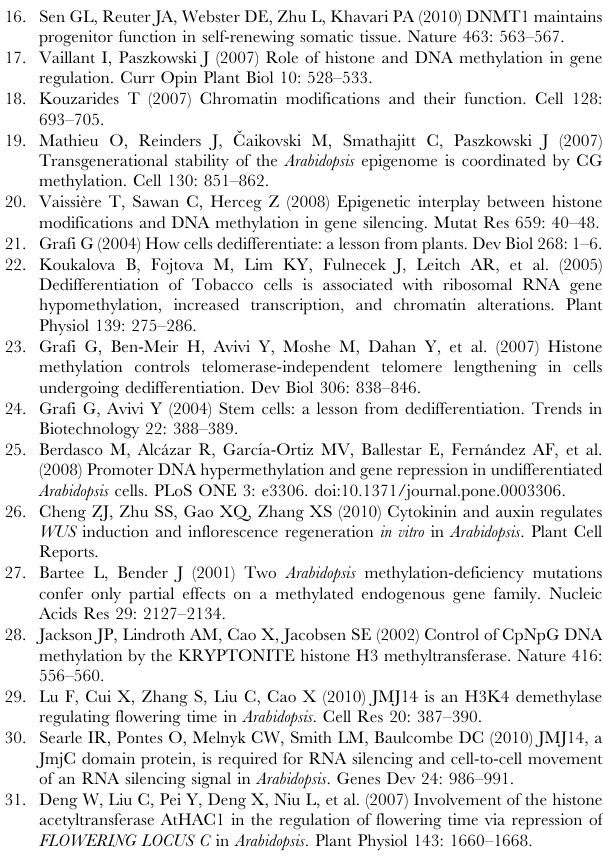
Figure S2 MET1 mutation promotes shoot regeneration in Arabidopsis using roots as explants. Calli of the wild type (Ws) and the met1 mutant were cultured on SIM for 6 to 18 days. Scale bars, Figure S3 Expression patterns of WUS were changed in met1 and kyp-2 mutants. In situ hybridization of WUS expression in calli of the wild type (Ws) cultured on SIM for A) 0 day, B) 4 days and C) 6 days, and that of met1 mutant cultured on SIM for D) 0 day, E) 4 days and F) 6 days. In situ hybridization of WUS expression in calli of the wild type (L er ) cultured on SIM for G) 0 day, H) 4 days and I) 6 days, and that of kyp-2 mutant cultured on SIM for J) 0 day, K) 4 days and L) 6 days. Scale bars, 50 m m. Figure S4 Expression patterns of candidate genes validated by qRT-PCR. Total RNAs were isolated from calli of wild type and met1 cultured on SIM at the indicated time points, and the transcripts of genes ARF3 , ARF4 , IAA18 , BLH7 , ANT , AS1 , CKX1 , and ARR15 were measured by qRT-PCR. Three independent RNA preparations were analyzed for each time point. Mean values were calculated from triplicate qRT-PCR analysis with standard errors. The relative expression level of each gene, corresponding to the expression level of TUBULIN2 , was calculated using the comparative C(T) method. Table S1 The percentage of the calli with WUS expressing signals detected by in situ hybridization.